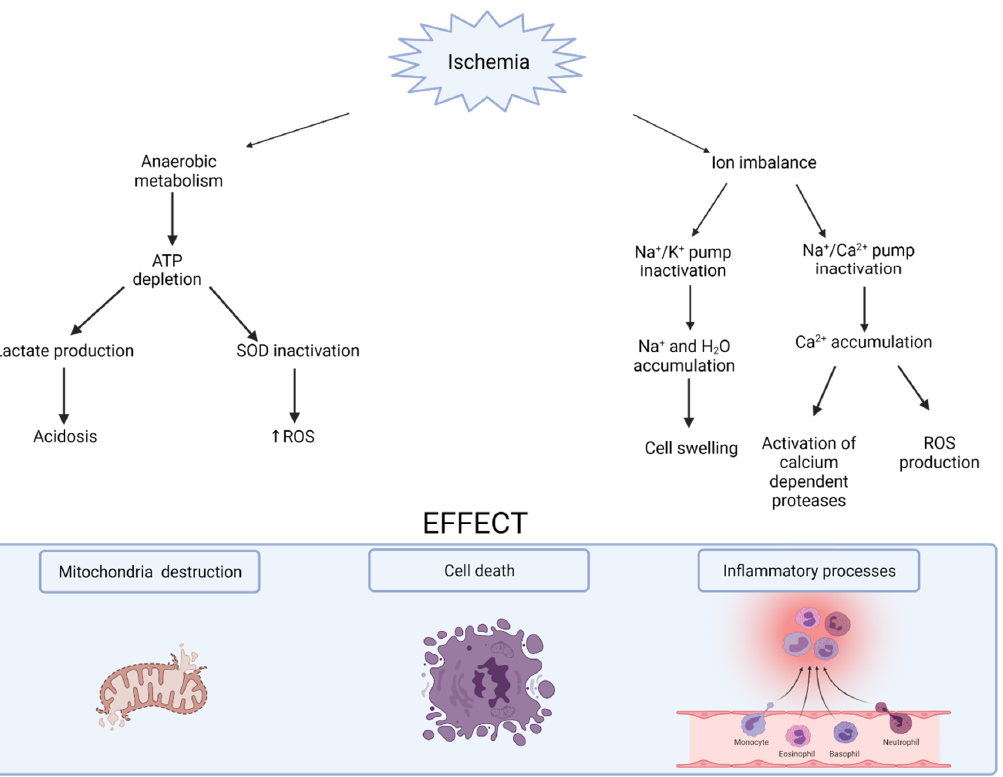
Figure 1. The effect of ischemia on cell metabolism. Legend: SOD—superoxide dismutase; ATP— adenosine 5’ ‐ triphosphate; ROS—reactive oxygen species.